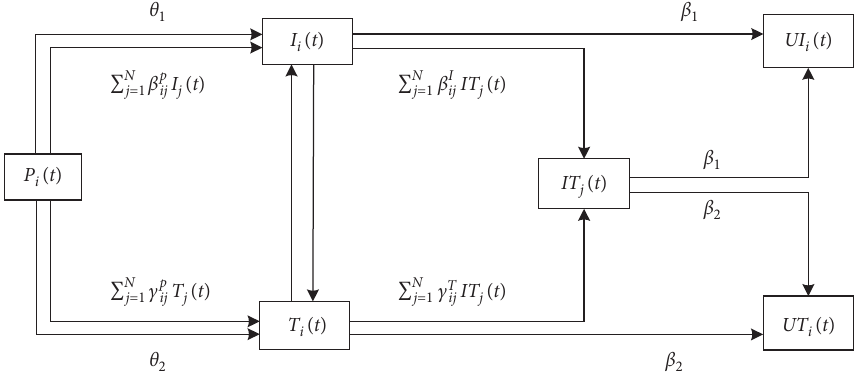
Figure 1: Diagram of traditional and innovative product information mixed spreading